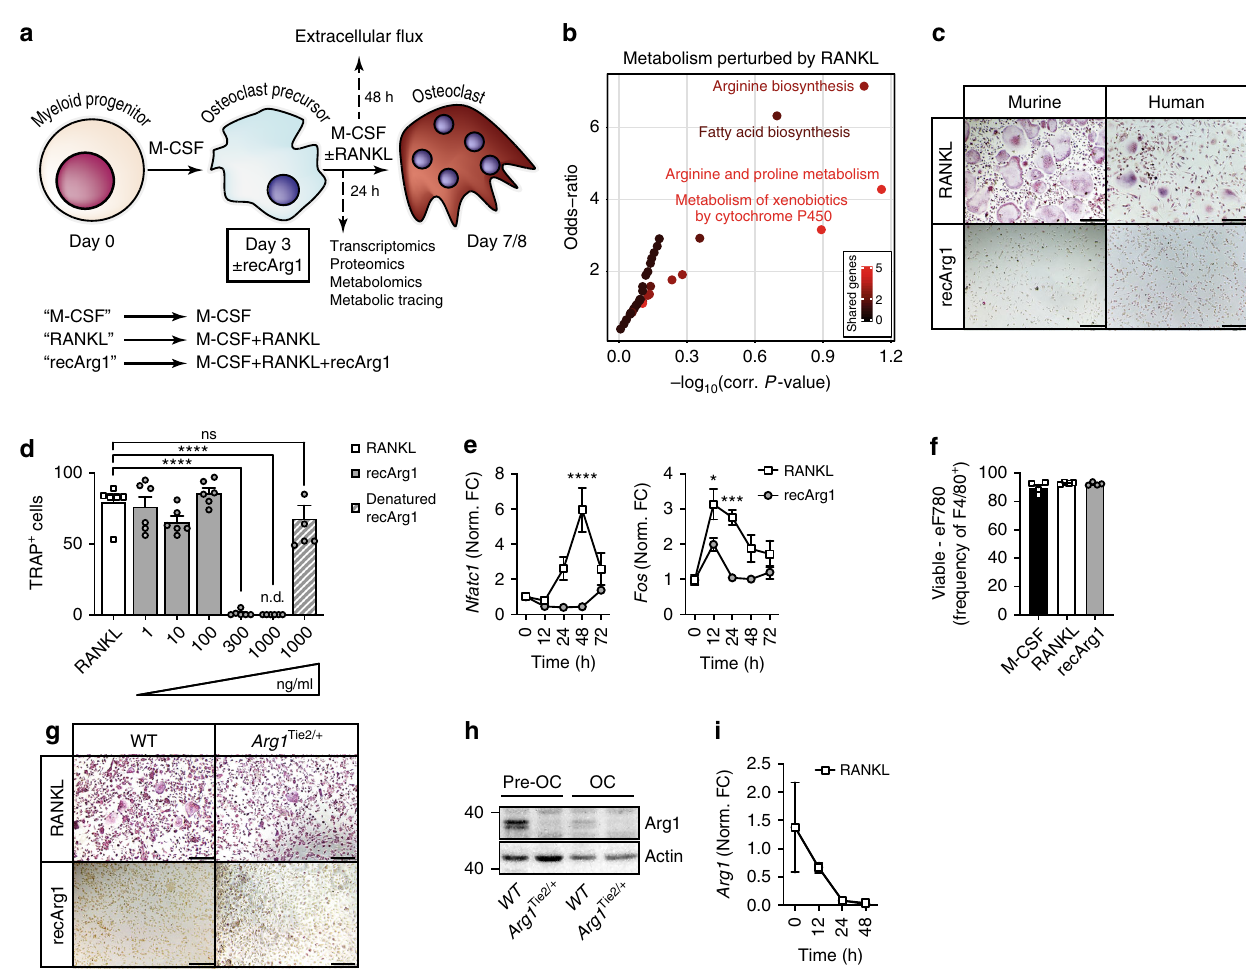
Fig. 2 Extracellular arginine is essential for RANKL-induced osteoclastogenesis. a Schematic of systems-wide approaches performed to understand the effect of recArg1 on RANKL dependent osteoclastogenesis. b KEGG metabolic enrichment of differentially expressed genes upon RANKL treatment. c Representative TRAP stainings depicting that recArg1 abolishes murine and human RANKL-induced osteoclastogenesis. d Quanti fi cation of murine data depicted in c ( n = 6). e qRT-PCR time course of Nfatc1 and Fos ( n = 3). f Quanti fi cation of viable cells 24 h post RANKL/recArg1 treatment ( n = 4). g , h Osteoclastogenesis is unchanged by Arg1 de fi ciency. TRAP stainings ( g ) and Western blots of ARG1 in preosteoclasts (Pre-OC) and osteoclasts (OC) ( h ). i qRT-PCR time course of Arg1 ( n = 3). Data are mean ± SEM, * P < 0.05, *** P < 0.001, **** P < 0.0001, one-way ANOVA ( d ) and two-way ANOVA post-hoc pairwise comparisons with Bonferroni correction ( e ). Scale bar represents 200 µ m ( c , g ). Source data are provided as a Source Data fi